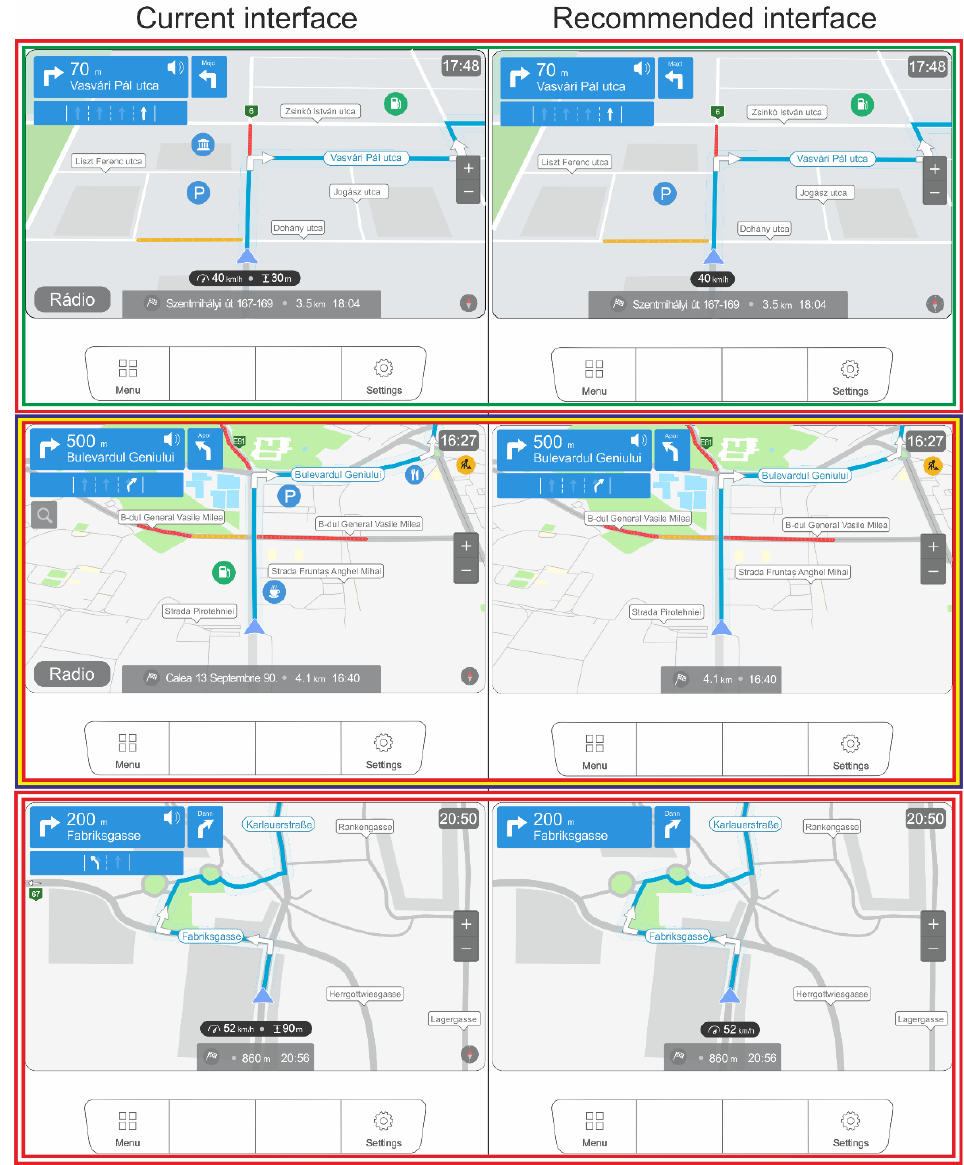
Figure 10. The current and the recommended interfaces by country—Hungary, Romania and Aus- tria.